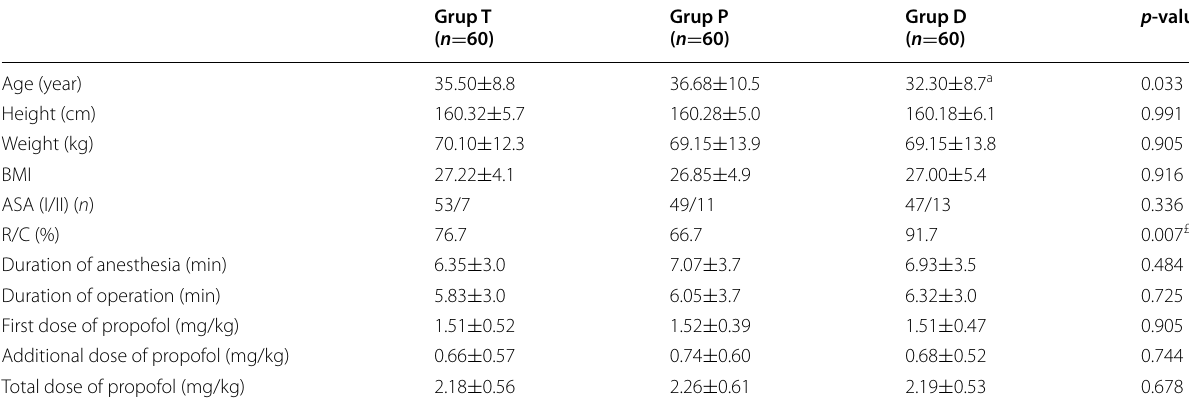
Values are expressed as mean standard deviation or n . a Groups with dexketoprofen trometamol and paracetamol were found to have significant differences. £ ± Since the significance value was 0.007, the relationship between the patient diagnosis and the groups was statistically